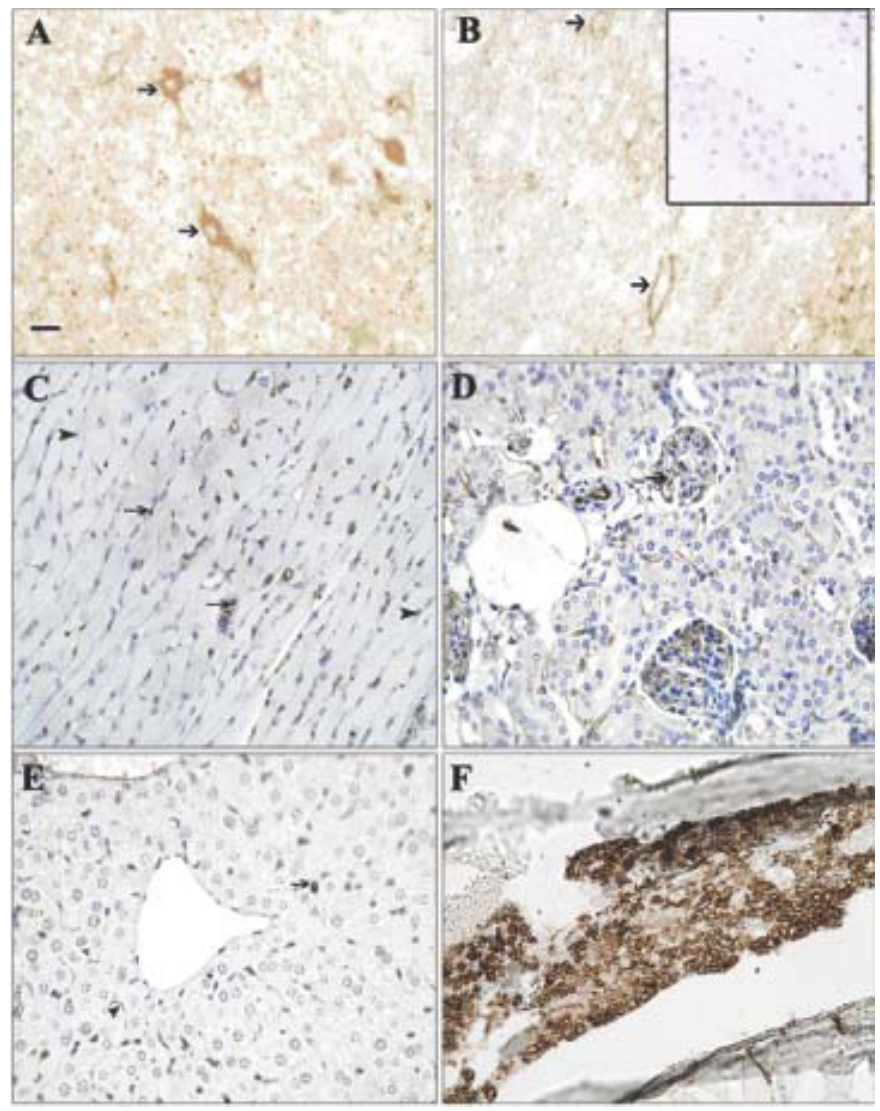
Figure 2. Expression pattern of GS-I binding to normal cells. Tissues from a naïve control mouse were labeled with GS-I. ( A ) Brain: Neurons (arrows) were labeled in a cytoplasmic and membranous fashion; ( B ) Spinal cord: Neurons were labeled in a membranous pattern; ( C ) Heart: Endothelial cells in the interstitium and in small arteries (arrows) were labeled. Myofibers (arrowheads) were not stained; ( D,E ) Kidney, Liver: Endothelial cells (arrows) bound GS-I weakly to moderately. Hepatocytes and renal tubular and glomerular epithelial cells did not bind GS-I; ( F ) Bone marrow: Hematopoietic cells bound GS-I strongly in a membranous and cytoplasmic pattern; ( A,B,C ) 200× magnification, bar equals 40 μ m. ( D,E,F ) 400× magnification, bar equals 20 μ m. No staining was observed in sections stained with biotin alone ( inset, B